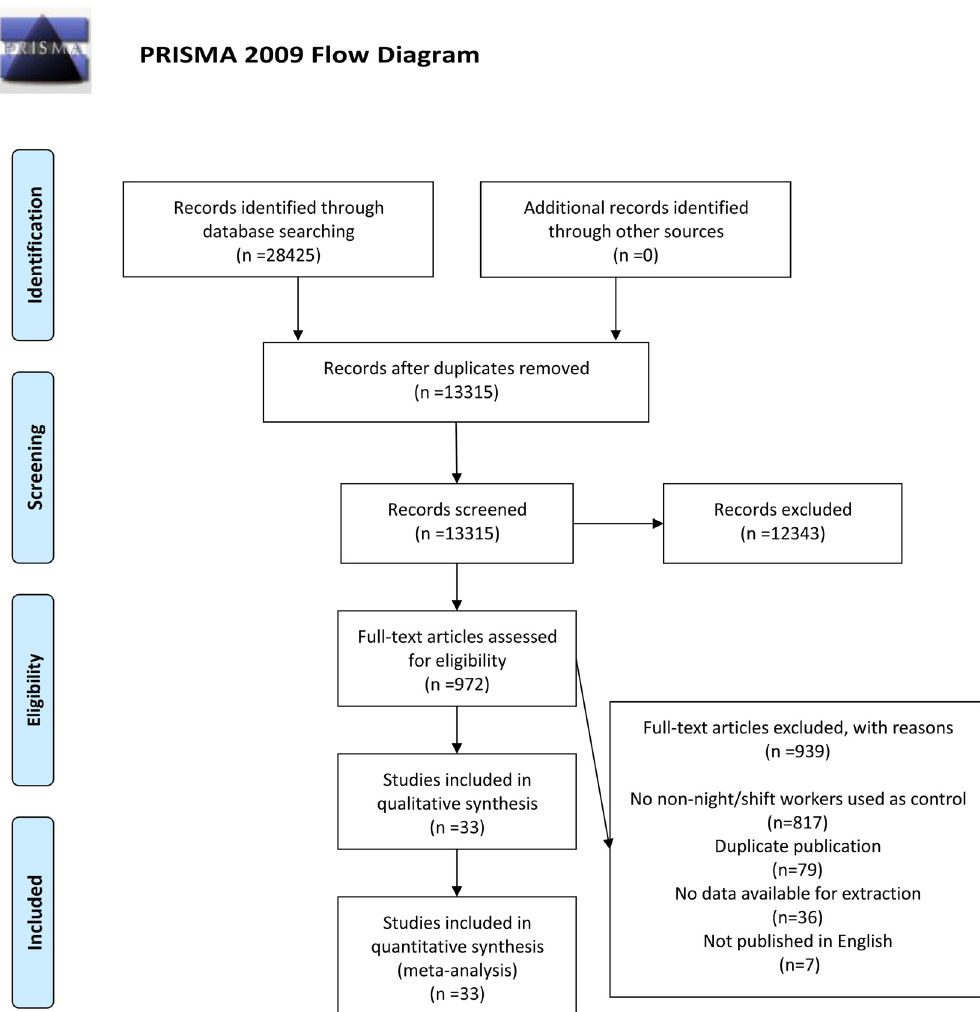
Figure 1: A schematic fl ow for the selection of articles included in this meta -